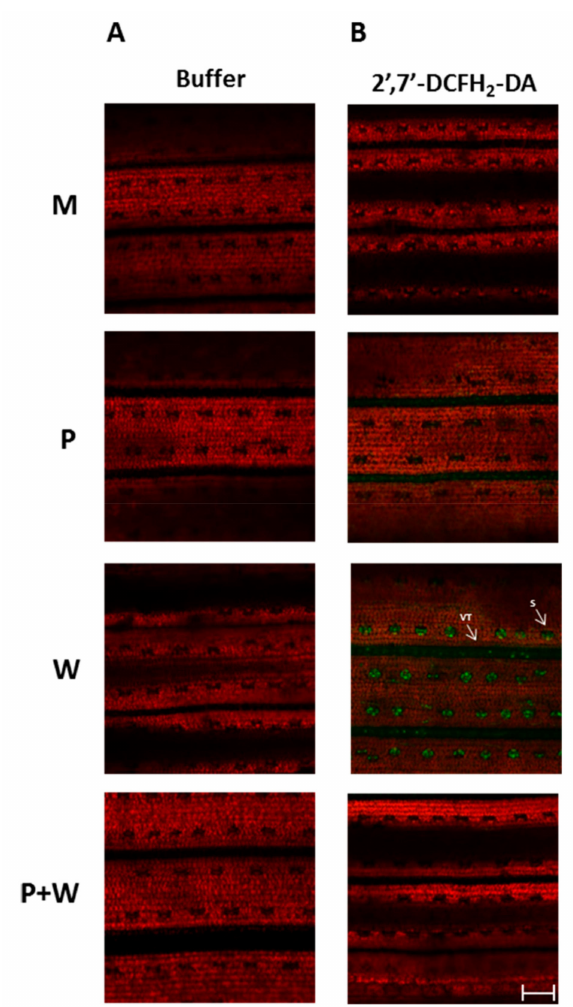
Figure 6. Detection of H 2 O 2 in rice leaves using bu ff er (negative technical control) ( A ) or 2 (cid:48) ,7 (cid:48)